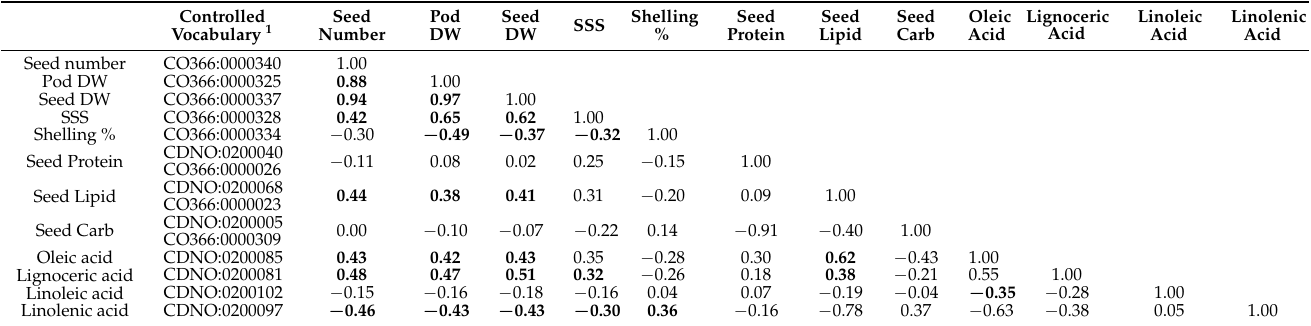
Table 5. Correlation analysis output of 40 bambara groundnut lines for the following traits: seed number, pod dry weight, seed dry weight, single seed size, shelling percent (%), seed lipid, protein, carbohydrate, and oleic, lignoceric, linoleic, and linolenic acids. Pearson’s correlation coefficient (r values) were considered significant at p < 0.05 for r > 0.312 ( n = 40, d.f = 38). Significant correlations between traits are in bold. Carb = carbohydrate; DW = dry weight, SSS = single seed size.